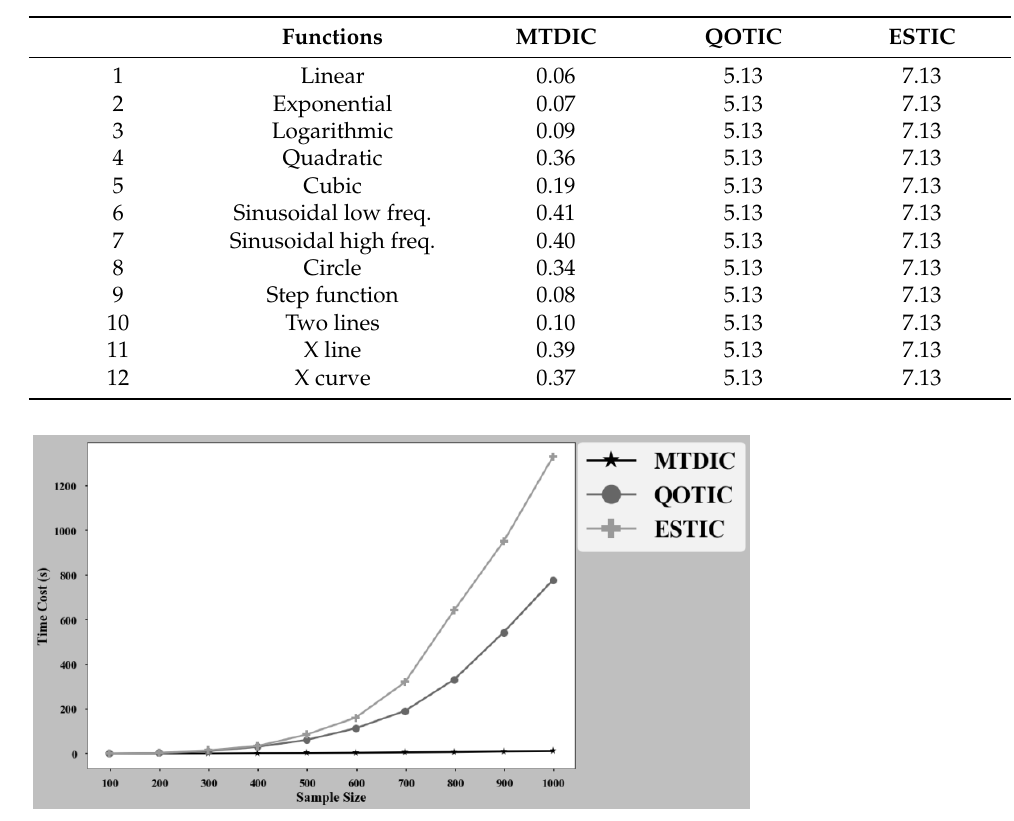
Table 4. Time cost of MTDIC, QOTIC, and ESTIC.